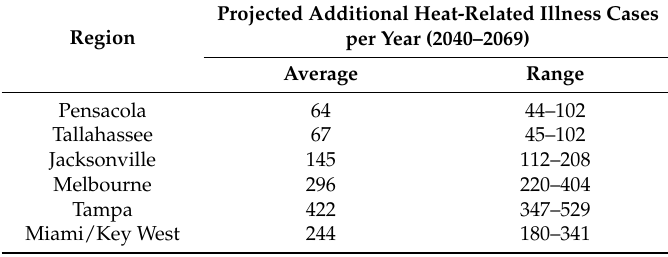
Table 3. Projected additional heat-related illness cases per year, by NWS region averaged across 10 global circulation models.